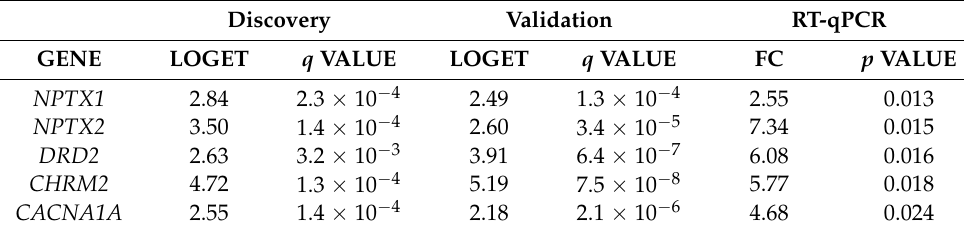
Figure 2. Volcano plots with overlapped and selected genes. Table 4. RNA-seq and RT-qPCR results of selected genes.